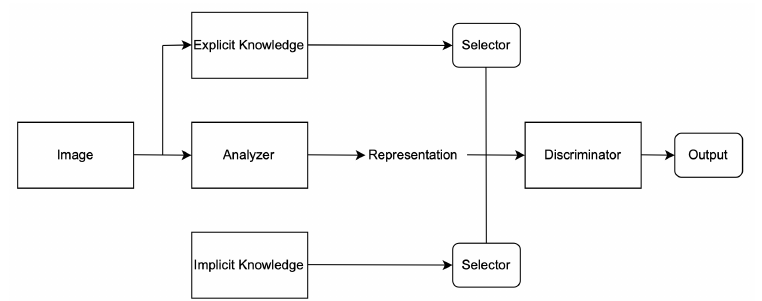
Figure 3. YOLOR system architecture.